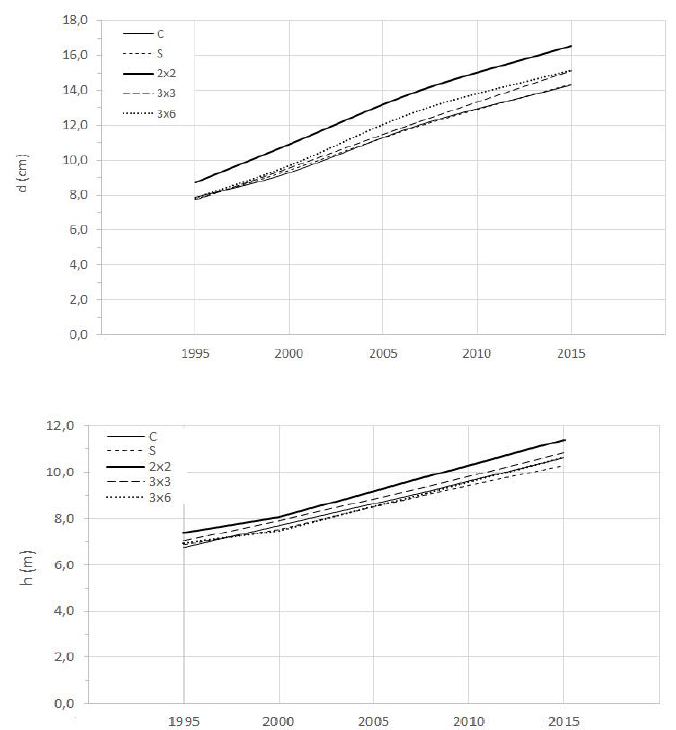
Figure 3. Diameter ( upper ) and height ( lower ) growth of trees over time for different silvicultural interventions in the Pyrenean oak coppice. All interventions provided higher diameter growth compared with the control, although only strip thinning was significantly different. For the tree height, 2 × 2 thinning provided a higher increment, although not significantly different from the other strip thinning. Table 3. Mean tree diameter increment ( i d ) for different crown classes (dominant, intermediate, suppressed) in Pyrenean oak coppice. The same letter in the column indicates the group subset and nonsignificant differences from the mean comparison test, at the 5% significance